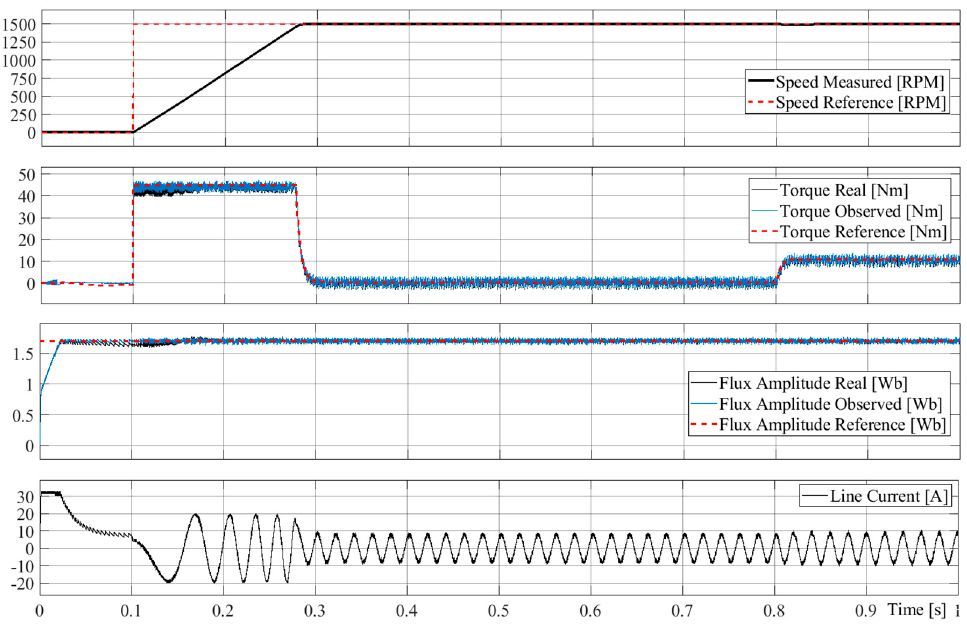
Figure 8. Startup of the motor 0 to 1500 RPM—delta-connected winding.